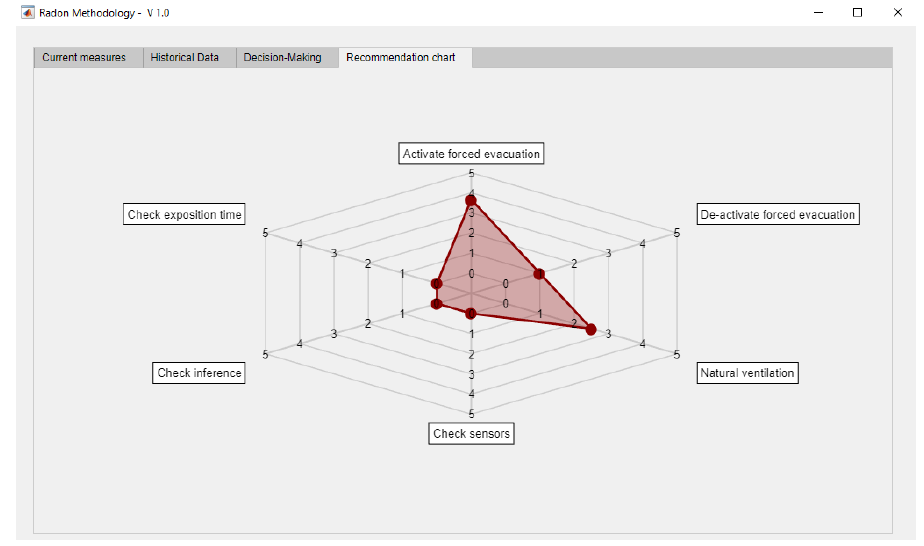
Figure 10. Spider-web diagram.